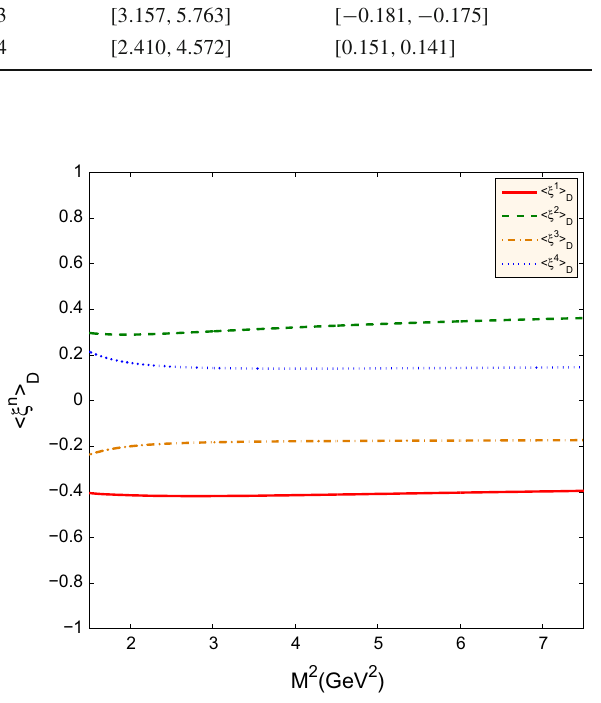
Fig. 3 The D -meson leading-twist DA moments (cid:3) ξ n (cid:4) D ( n = 1 , 2 , 3 , 4 ) versus the Borel parameter M 2 , where all input parameters are set to be their central values. The solid, dashed, dash-dotted and dotted lines are for